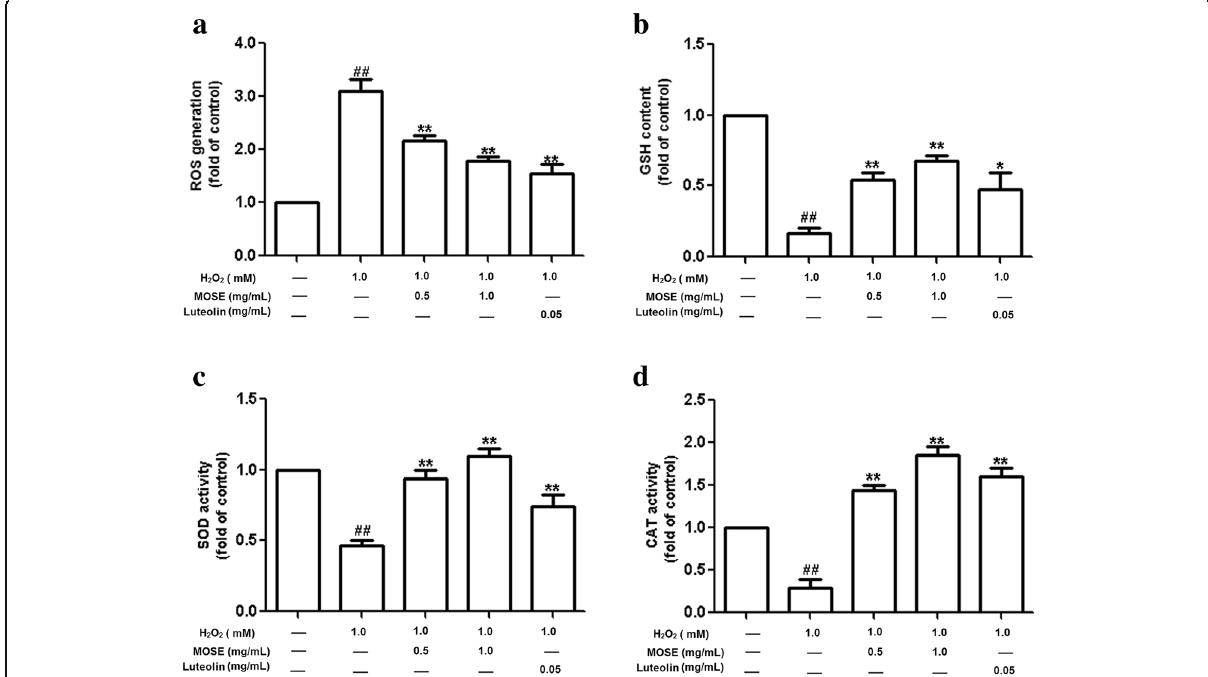
Fig. 3 Effects of MOSE and luteolin on ROS production and SOD, CAT activities in lenses. The fluorescent probe DCFH-DA was used to detect the ROS level in lenses pre-treated with MOSE (0.5 and 1.0 mg/mL) or luteolin (0.05 mg/mL) before H 2 O 2 exposure. The fluorescent intensities are summarized in a . GSH content ( b ), and SOD ( c ) and CAT ( d ) activities were measured in lenses pretreated with MES or luteolin before H 2 O 2 exposure. Data are expressed as the mean ± SEM (n = 6); ## P < 0.01, compared with the normal control group; * P < 0.05, **P < 0.01, compared with the H 2 O 2 treatment